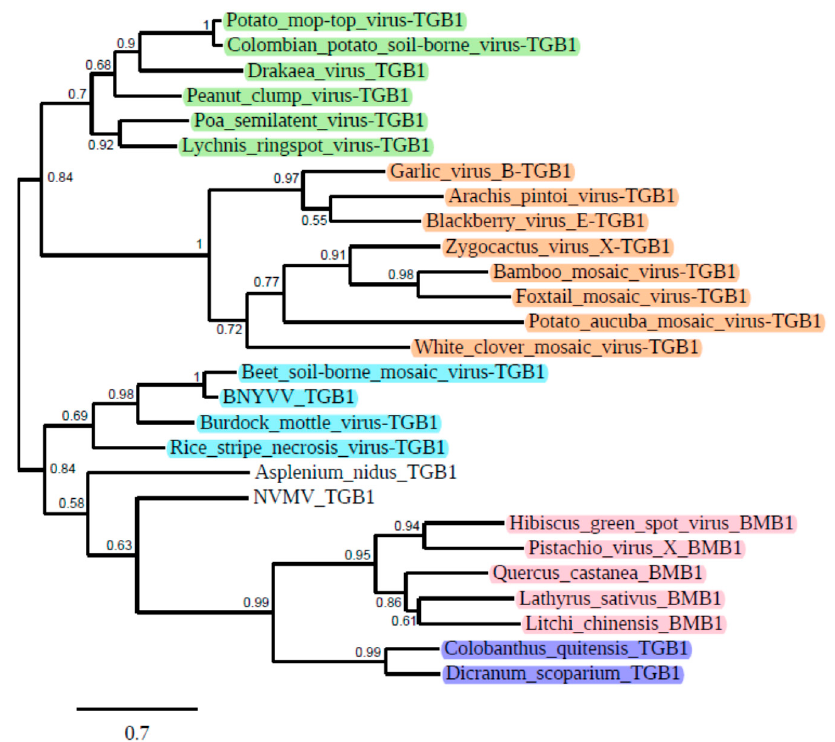
Figure 1. Phylogenetic analysis of the helicase domains derived from the aligned deduced amino acid sequences of the selected proteins encoded by TGBs and BMBs. The phylogenetic unrooted tree was constructed using the maximum likelihood method based on the amino acid sequence alignments (http://www.phylogeny.fr/simple_phylogeny.cgi, accessed on 26 May 2022). The bootstrap